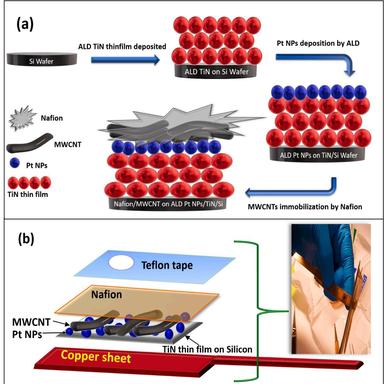
FIB-SEM images of ALD TiN thin film deposited on Si wafer: (a) cross-sectional image of TiN thin film, (b) complete FIB-SEM thickness film: 100 nm TiN by 5376 ALD cycles, and (c) top view of the cross-sectional cutting with undercut layers, (d) ellipsometry map thickness of ALD TiN on Si wafer.